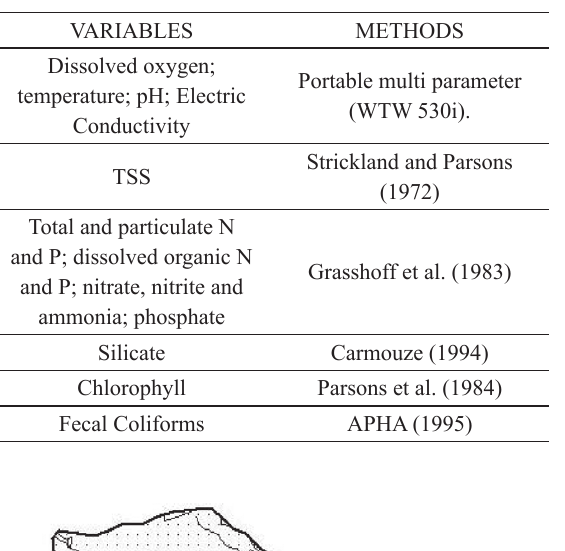
Methods used in the analyses of the studied variables.